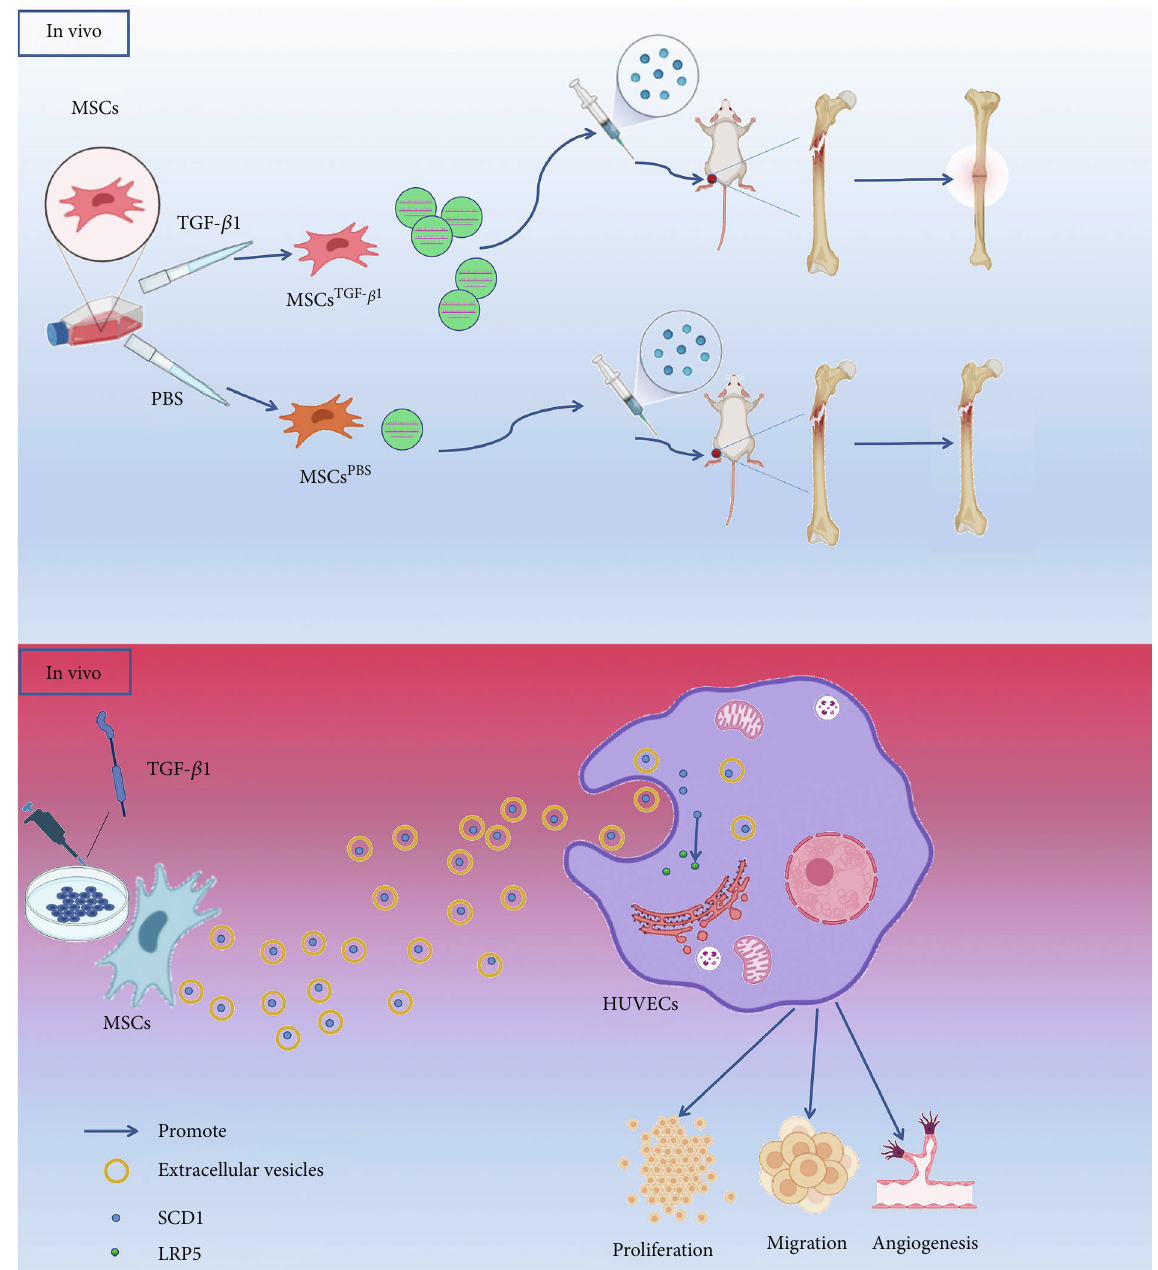
Figure 9: Schematic representation depicts that bone fracture healing is promoted in mice after transplantation with MSC TGF- β 1 -EVs in vivo. MSC TGF- β 1 -EV-SCD1 promotes HUVEC proliferation, angiogenesis, and migration by interactions involving LRP5 in vitro . MSCs: mesenchymal stem cells; EVs: extracellular vesicles; HUVECs: human umbilical vein endothelial